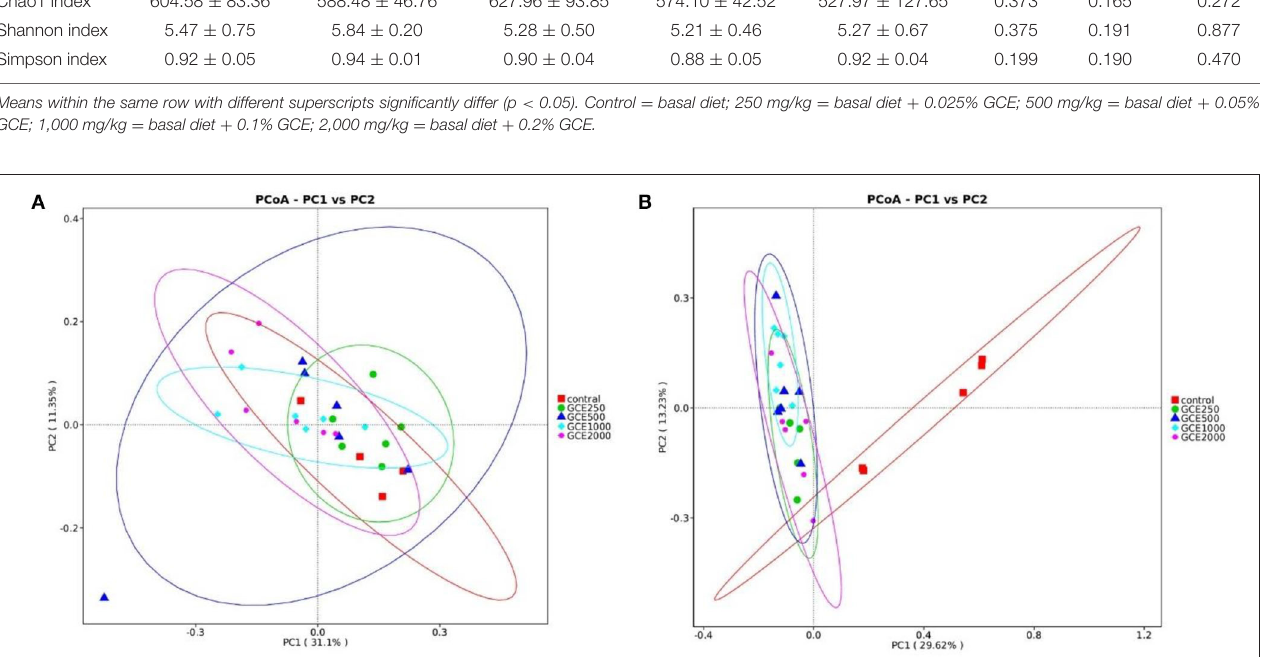
Anova Linear Quadratic